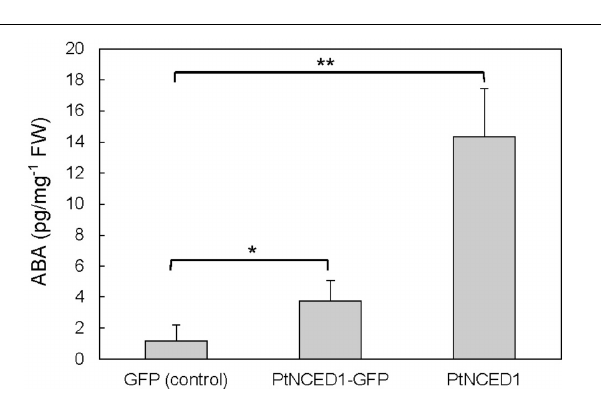
FIGURE 5 | Abscisic acid content in the PtNCED1 transiently expressed tobacco leaves. The materials were the same as in Figure 4 . N. benthamiana leaves were agroinfiltrated to express the GFP, PtNCED1-GFP, or PtNCED1 protein for 3 days. Data are mean ± SD from three biological replicates. Significant difference was set at P ≤ 0.05 ( ∗ ) and P ≤ 0.01 ( ∗∗ ) by unpaired Student’s t